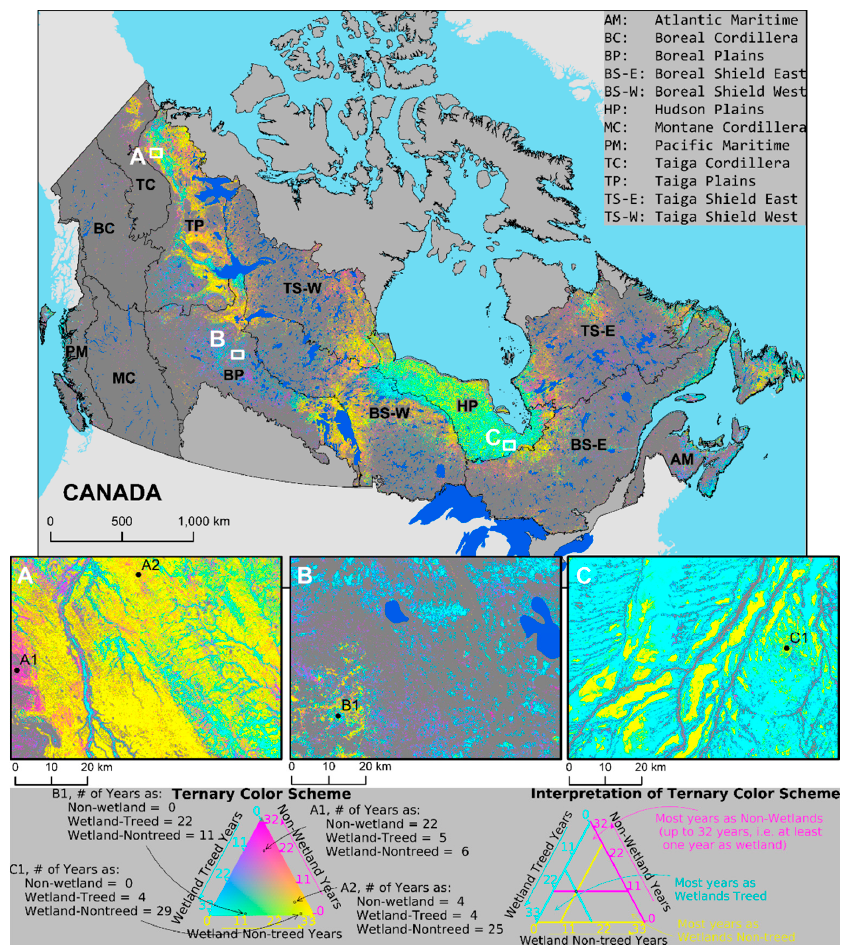
Figure 5. Number of years that a given wetland-occurring pixel (i.e., flagged as wetlands at least once in the 33 years) was classified as a wetland (treed or non-treed). Each pixel is rendered according to the ternary color legend at the bottom, with the pink hue relating to the number of years classified as non-wetland, the cyan color by the number of years classified as treed wetland, and the yellow color by the number of years classified as non-treed wetland. See bottom inset for an interpretative guide. Grey represents non-wetland. Waterbodies are shown in blue for context.